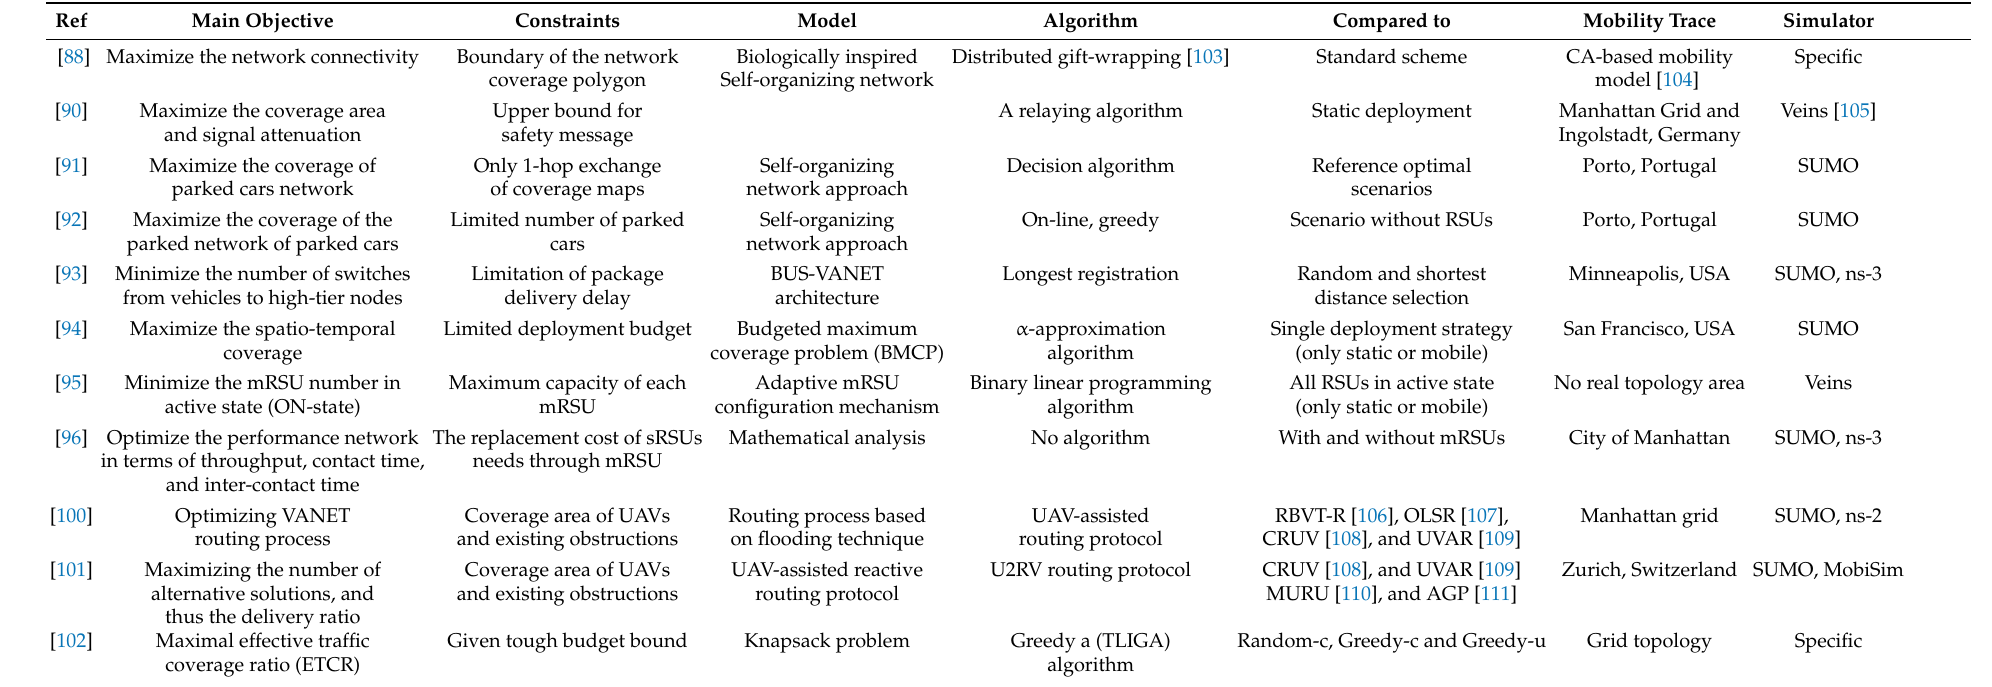
Table 4. Qualitative overview of dynamic deployment